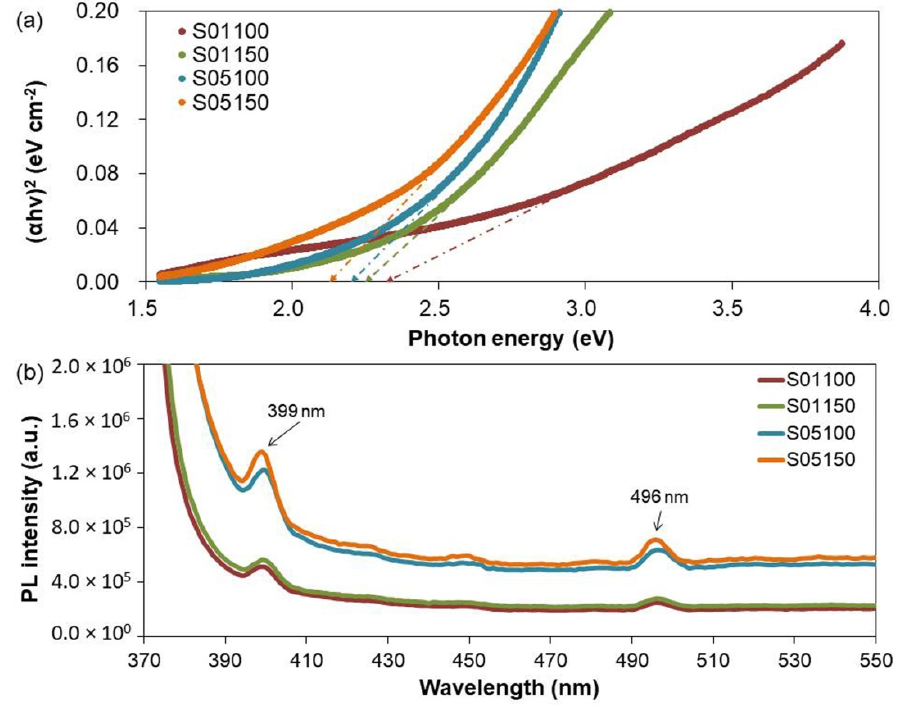
Figure 3. ( a ) The Tauc plot and ( b ) photoluminescence spectra of CuO thin